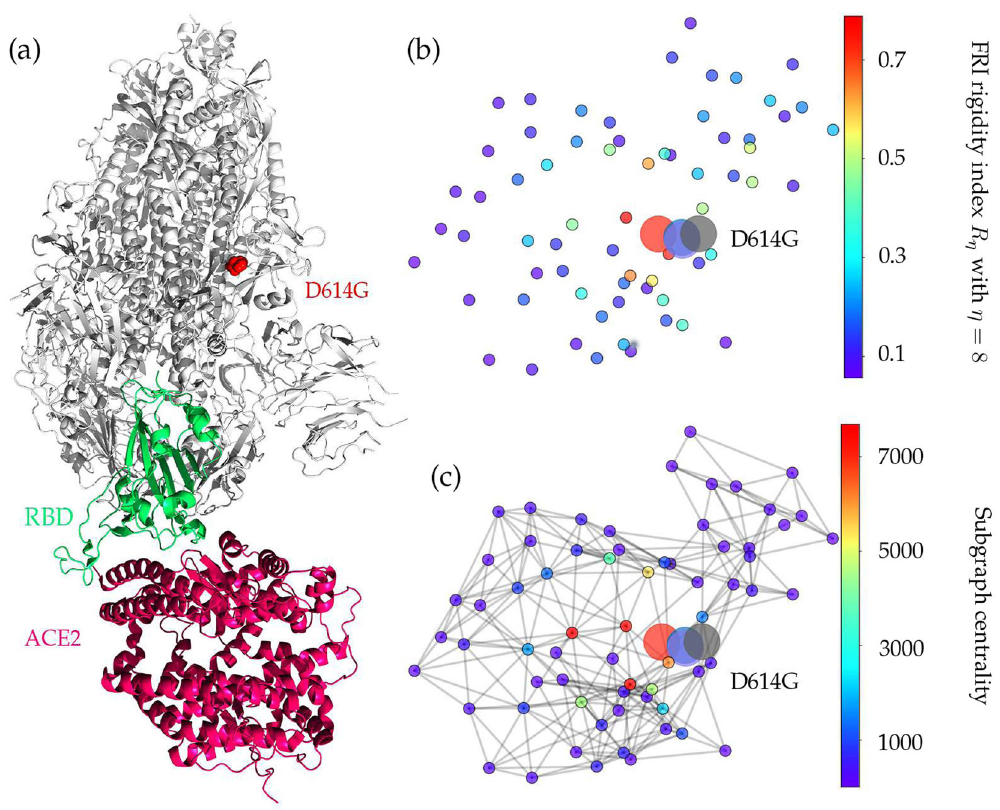
Fig. 4 The 3D structure and network analysis plot of SARS-CoV-2 S protein. a Illustration of S-protein and ACE2 interaction. The RBD is displayed in green, the ACE2 is given in red, and mutation D614G is highlighted in red. b The difference of FRI rigidity index between the network with wild type and the network with mutant type. c The difference of the subgraph centrality between the network with wild type and the network with mutant